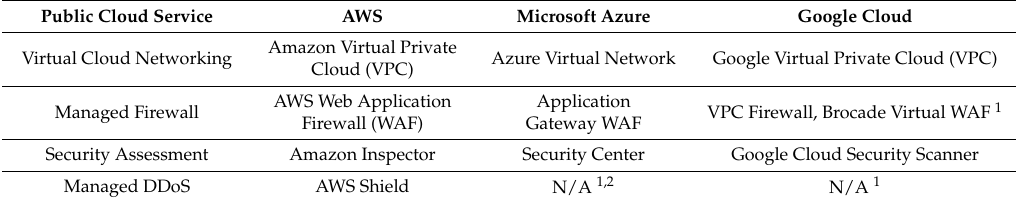
Table 3. Network and Security Public Cloud Services for Secure